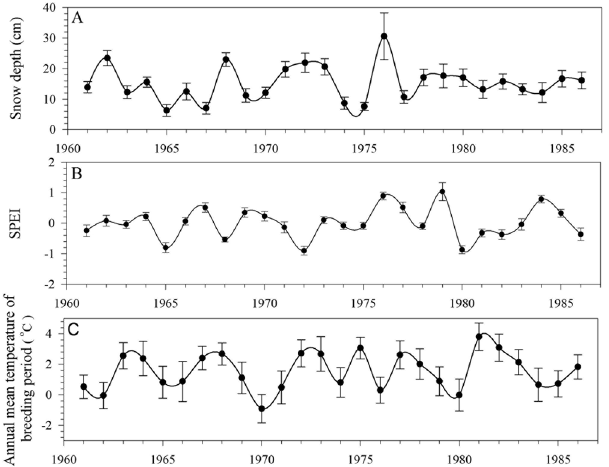
Figure 3. Overview of Climate Conditions between 1961 and 1986 in Inner Mongolia Note: SPEI stands for Standardized Precipitation Evapotransporation Index, a measurement of drought. Solid dot represents mean value, and error bars represent standard errors from the 11